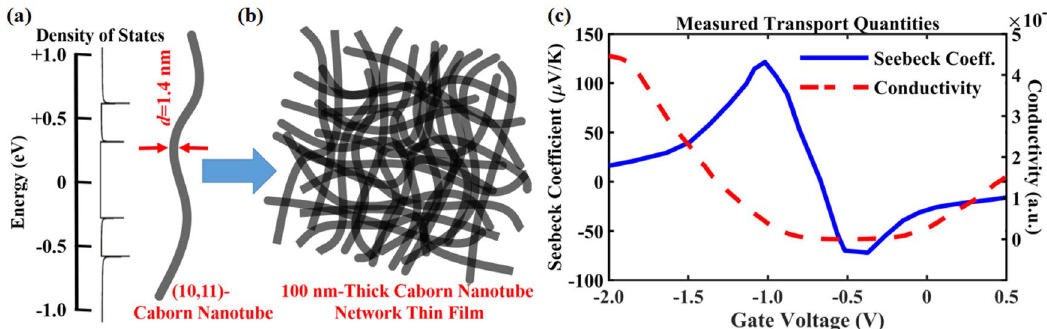
Figure 1. The 100 nm thin film of single-wall carbon nanotube network is synthesized and characterized by Yanagi et al. 48 The major chirality is of (11,10), corresponding to a diameter of 1.4 nm and a band gap of 0.535 eV. (a) The band structure of such a single carbon nanotube is clear. The electronic density of states is showing the peaks caused by van Hove singularities and hence marks the band edges of the semiconducting single-wall carbon nanotube. The first band edges for electrons and holes are marking the band gap, and the second band edges are 0. 260 eV and 0.268 eV apart from the bottom of conduction band and the top of valence band, respectively. (b) The band structure or band gap of the carbon nanotube network is not well investigated. The finite distribution of chiralities, imperfections within each nanotube, and the contact points between nanotubes may result in shift and smearing of the effective band edges for transport of this complex materials system. (c) The electrical conductivity (dashed red) and the Seebeck coefficient (solid blue) are experimentally measured by Yanagi et al. 48 at 300 K as a function of Fermi level.